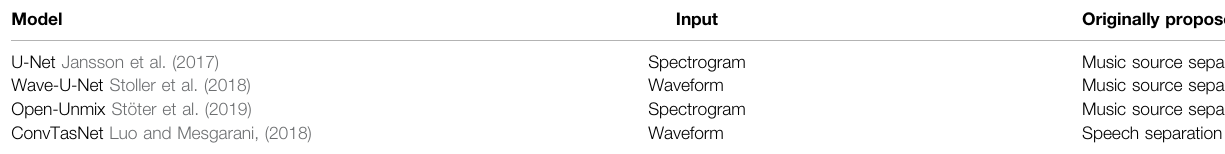
TABLE 2 | The models we adapt for voice segregation in SATB choirs.